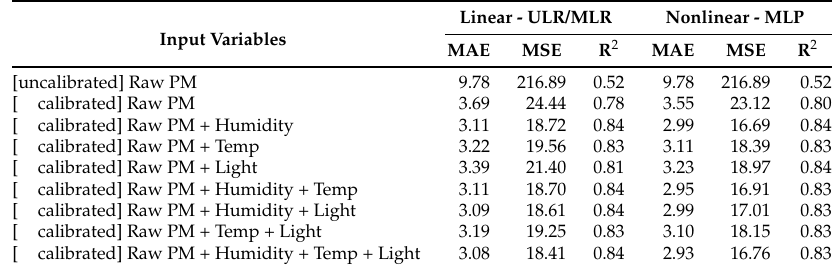
Table 4. Comparison of calibration performance by input variables (short-term: 80%—training dataset, 20%—test dataset, shuffled method, 5 min. sampling interval